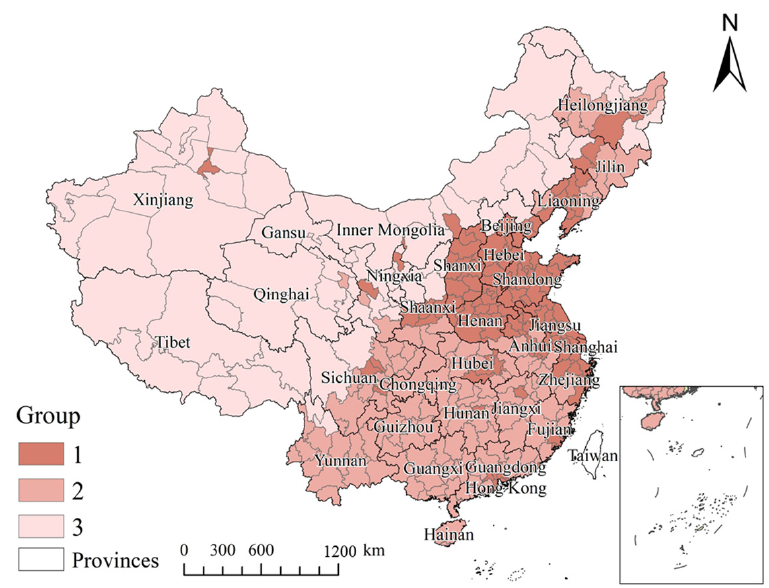
Figure 2. Clustering spatial distribution of cities in the mainland of China.